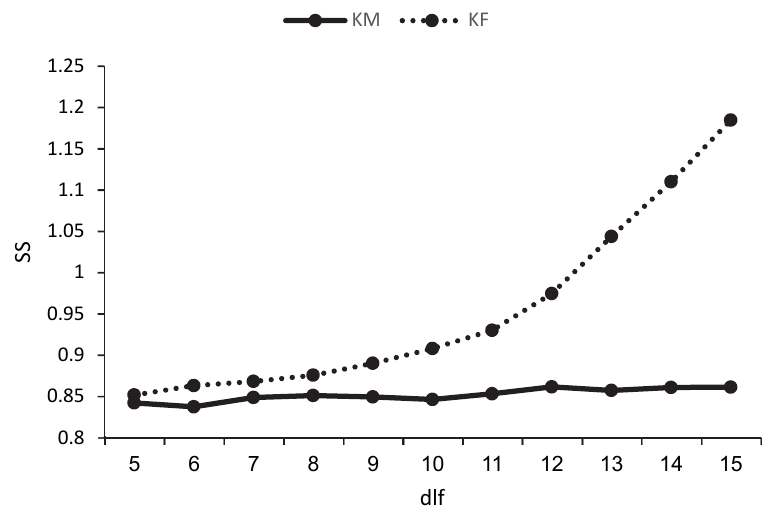
Fig. 5. Results achieved by the methods based on the SS when dlf varies According to Fi. 5, when dlf increases, the quality of clustering obtained by the KF increases. This is due to the fact that as dlf increases, the separation between the clusters increases as well. In such situation, using eigenvectors of the respective matrix leads to clearer distinction of the latent clusters. Thus, the quality of the clusters extracted by the KF significantly increases as dlf increases. However, KM is almost indifferent when dlf changes. This is because the KM focuses on the clustering ARs, not on the present attributes. In other words, since the structure of the graph of ARs does not significantly change when dlf varies, the differences between the clusters of the extracted ARs may refer to the random events of the respective algorithm. Moreover, one can easily find that in most cases, the KF reaches to the greater results than the